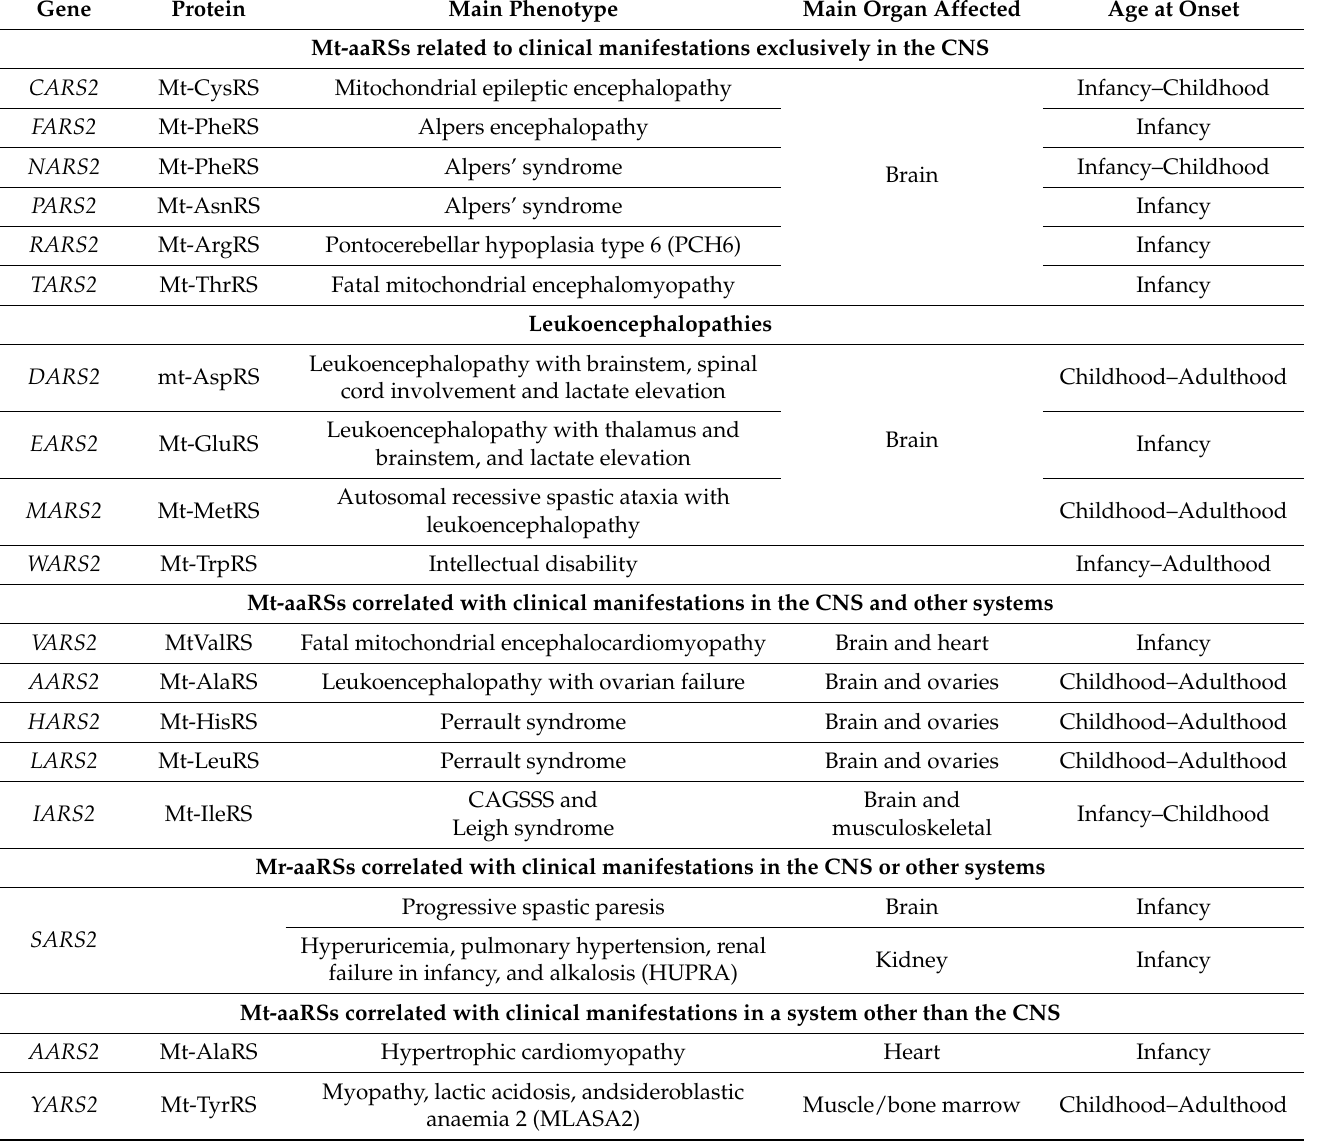
Table 6. Pathologies due to mutations on mitochondrial aminoacyl-tRNA synthetases. Adapted from